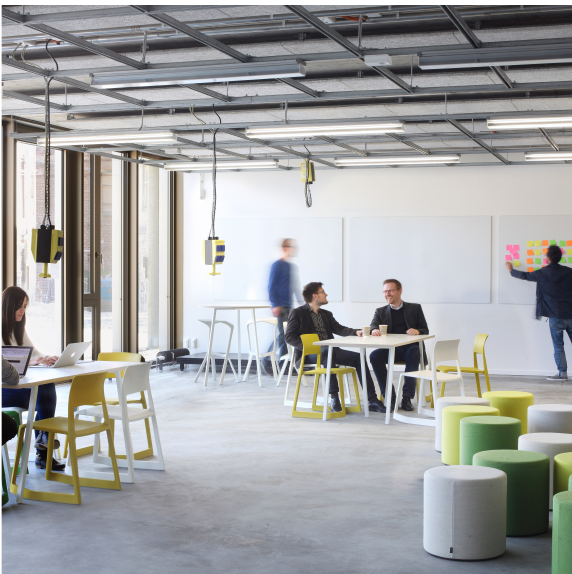
Fig. 6. Final idea lab in use (photo ©Eibe Sönnecken, used with permission from Birk Heilmeyer und Frenzel Architects).